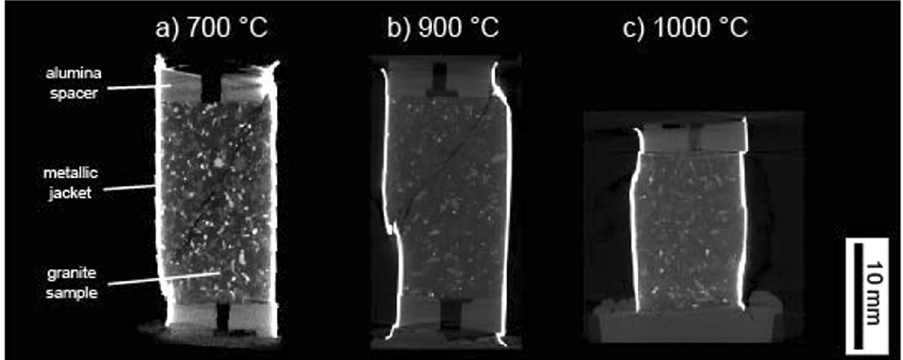
Figure 3. X-ray computed tomographic images of the samples of Westerly granite (thermally-shocked to 450 °C) deformed at an effective confining pressure of 100 MPa and an axial strain rate of 10 − 5 s − 1 (the deformation experiments shown in Fig. 2). ( a ) Sample deformed at 700 °C. ( b ) Sample deformed at 900 °C. ( c ) Sample deformed at 1000